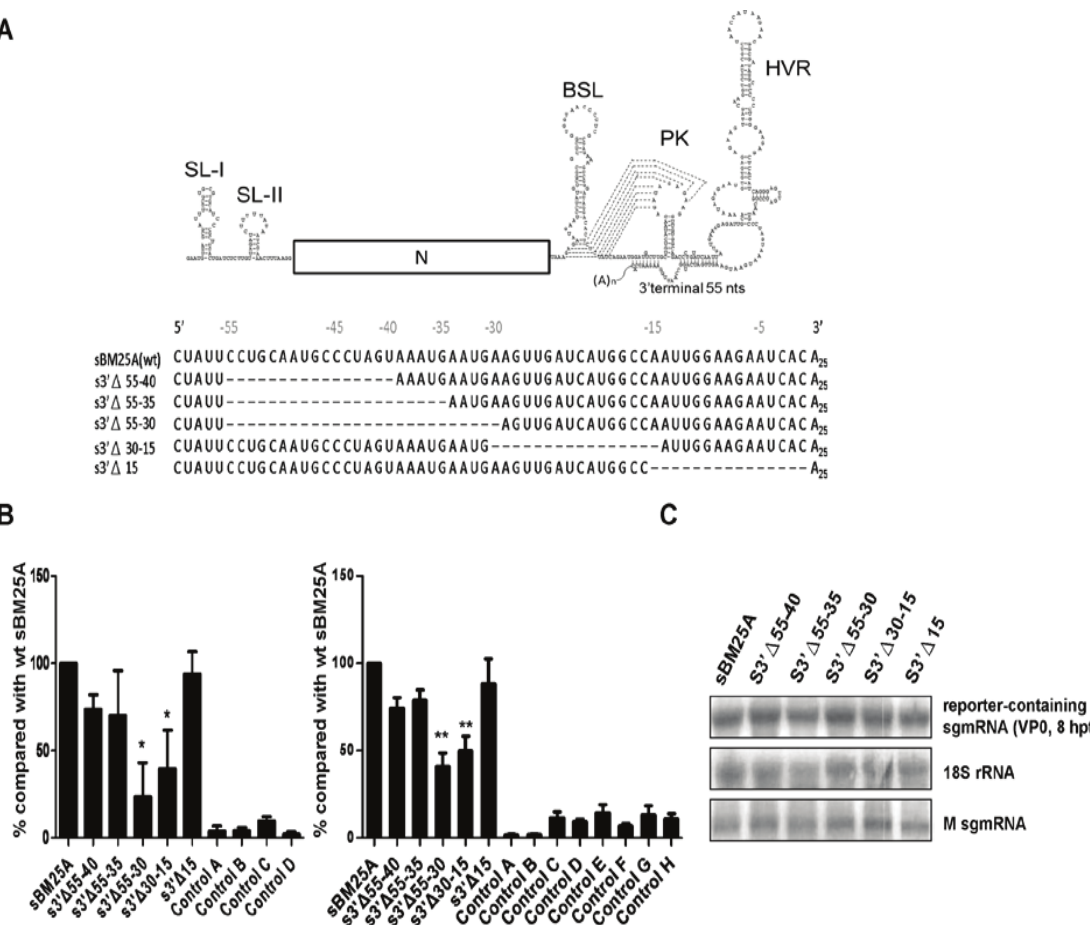
( − )-strand sgmRNA synthesis. ( A ) Upper panel: schematic diagram depicting the sgmRNA. The 3'-terminal 55 nts are indicated. Lower panel: constructs of sgmRNA with deletions within the 3'-terminal 55 nts. SL: stem-loop; BSL: bulged stem-loop; PK: pseudoknot; HVR: hypervariable region. ( B ) The relative efficiency of ( − )-strand RNA synthesis between the constructs, as measured by RT-qPCR with (left panel) or without (right panel) head-to-tail ligation. Left panel: Control A: total cellular RNA from mock-infected cells. Control B: total cellular RNA from BCoV-infected cells. Control C: total cellular RNA from sBM25A-transfected mock-infected cells. Control D: a mixture of BCoV-infected cellular RNA extracted at 8 hpt and 200 ng of sBM25A transcript. Right panel: Control A: total cellular RNA from mock-infected cells. Control B: total cellular RNA from BCoV-infected cells. Controls C–H: total cellular RNA from mock-infected cells transfected with sBM25A, s3' Δ 55–40, s3' Δ 55–35, s3' Δ 55–30, s3' Δ 30–15 and s3' Δ 15, respectively. ( C ) Measurements of reporter-containing sgmRNA, 18S rRNA and M sgmRNA (from helper virus) at 8 hpt of VP0 by Northern analysis. The values (B) represent the mean ± SD of three individual experiments. * p < 0.05, ** p <